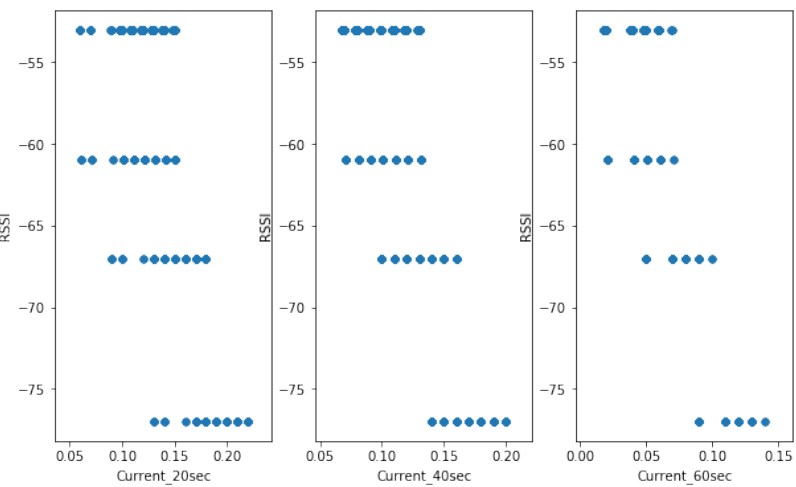
Figure 9. Current consumption vs. frequency of data